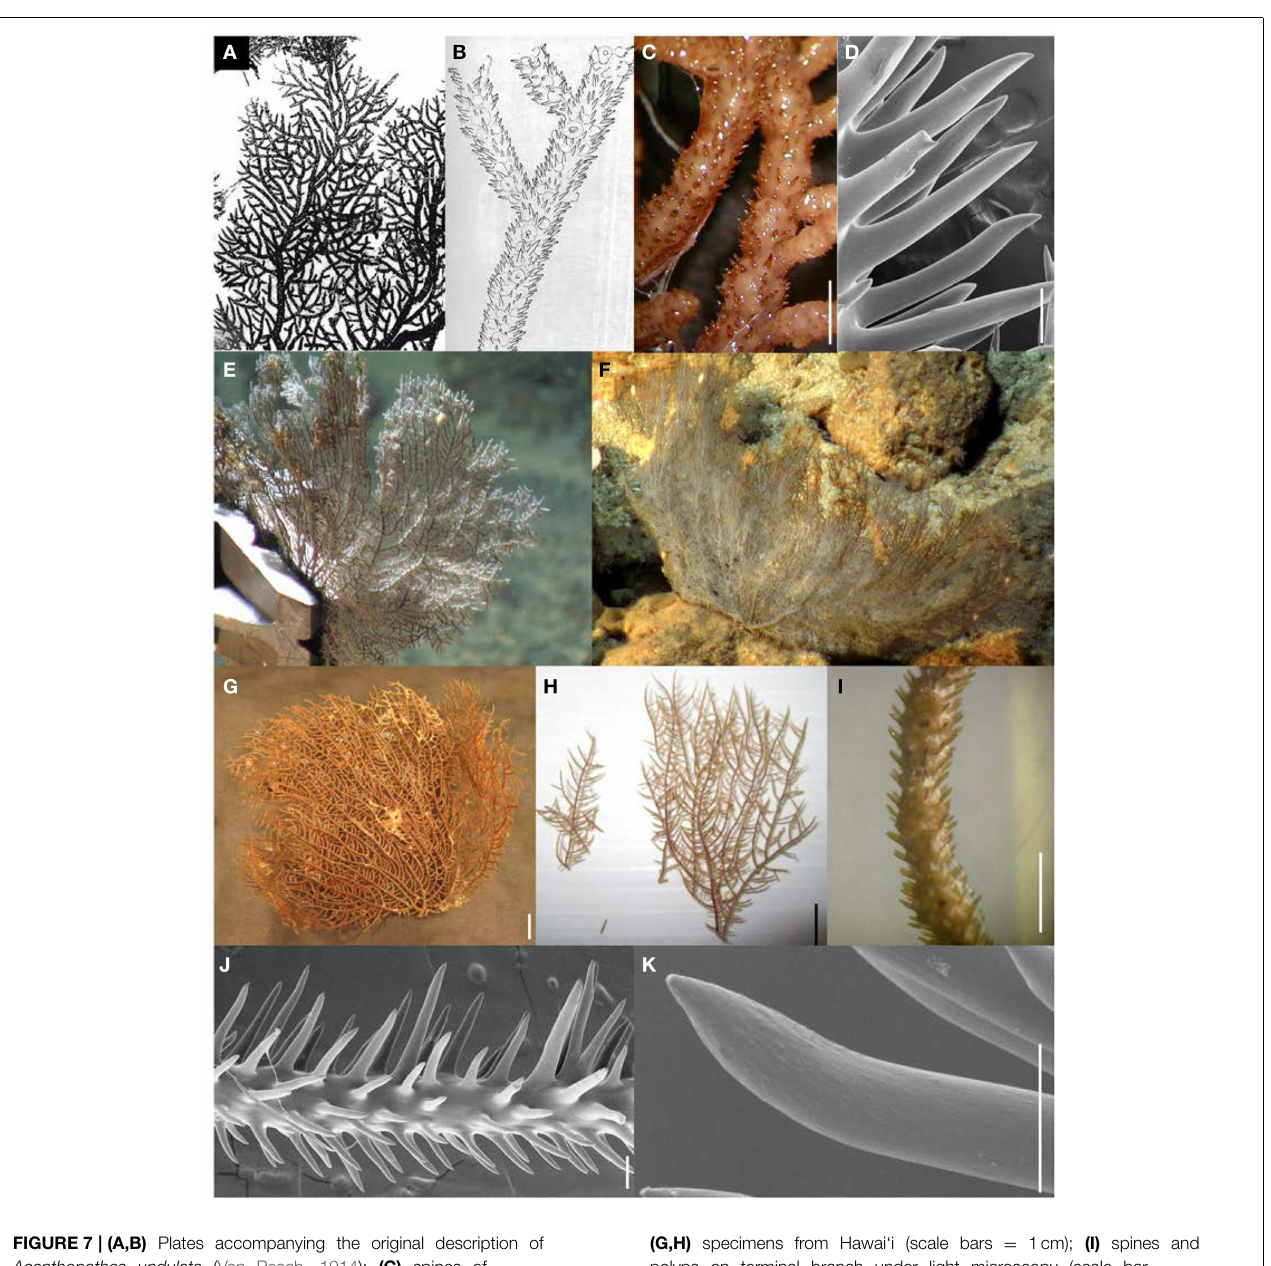
(G,H) specimens from Hawai‘i (scale bars = 1cm); (I) spines and polyps on terminal branch under light microscopy (scale bar